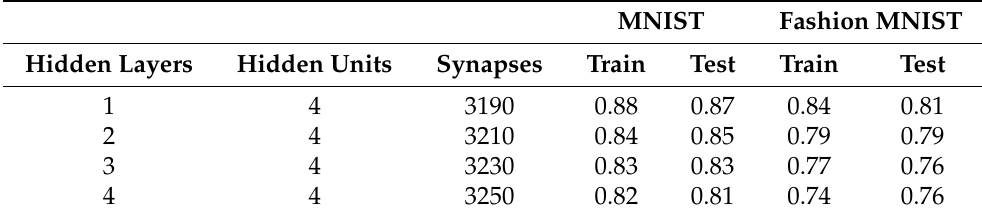
Table 4. Architectures for FdNN with less than 4096 synapses.